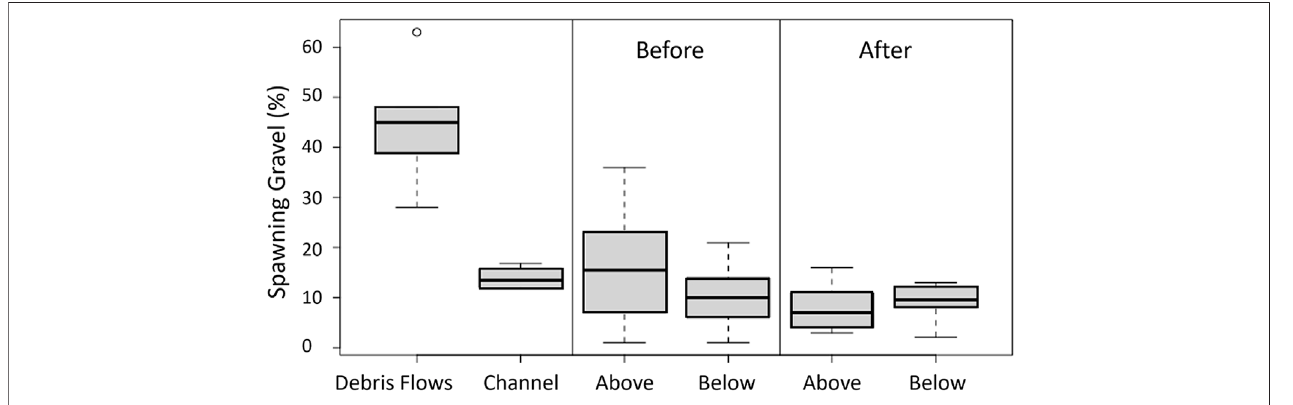
FIGURE 10 | Percent spawning gravel in debris fl ow snouts and Carmel River channel near the debris fl ows (left panel). BACI assessment (right two panels) uses the 2020 data (before) and 2021 data (after) of long term study sites DM (above) and SH (below). Site locations in Figure 4 .